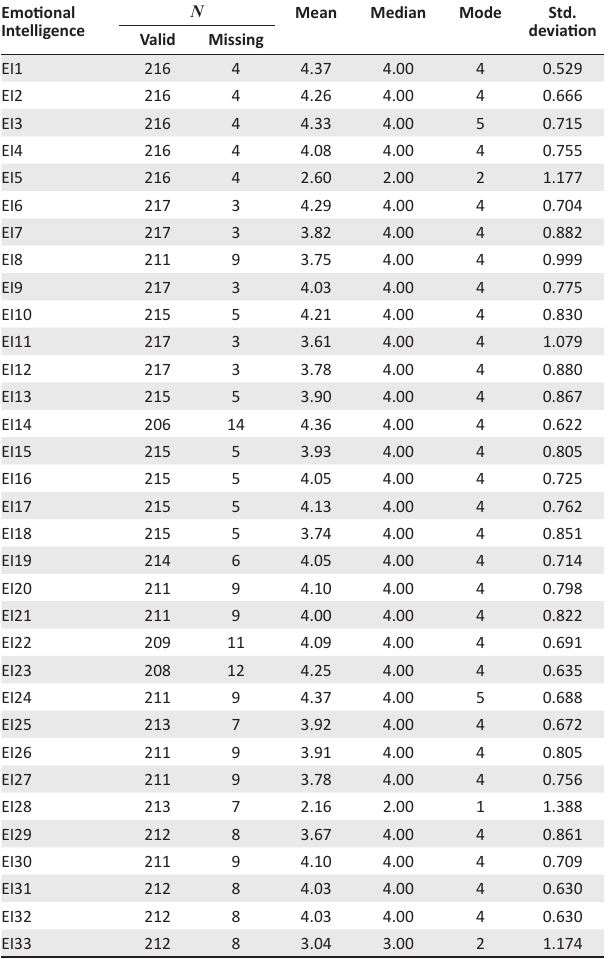
TABLE 2: Descriptive statistics on the Schutte Emotional Intelligence Scale. N Emotional Intelligence